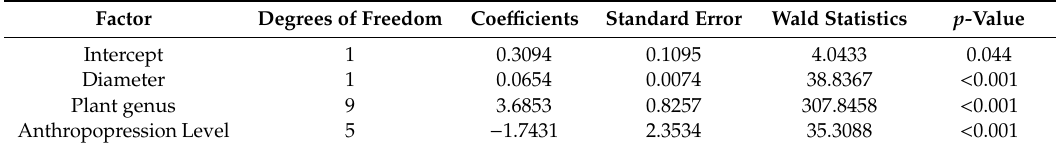
Table 5. The impact of plant diameter, plant genus and anthropopression level on observed di ff erences in the selection of woody plants by beavers along the Gwda River, according to a generalized linear model with a binomial